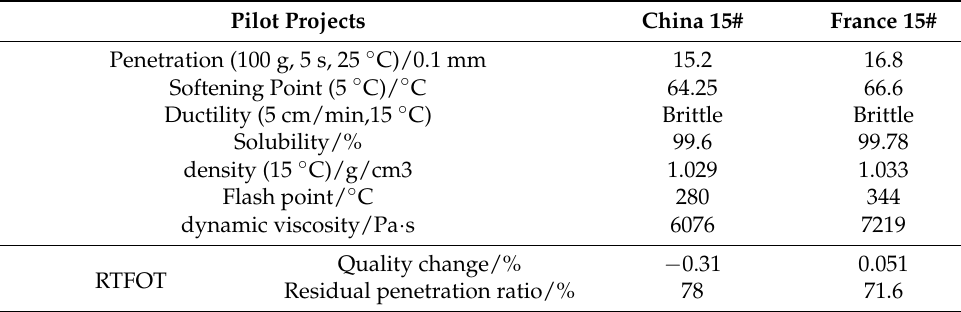
Table 2. Asphalt conventional technical